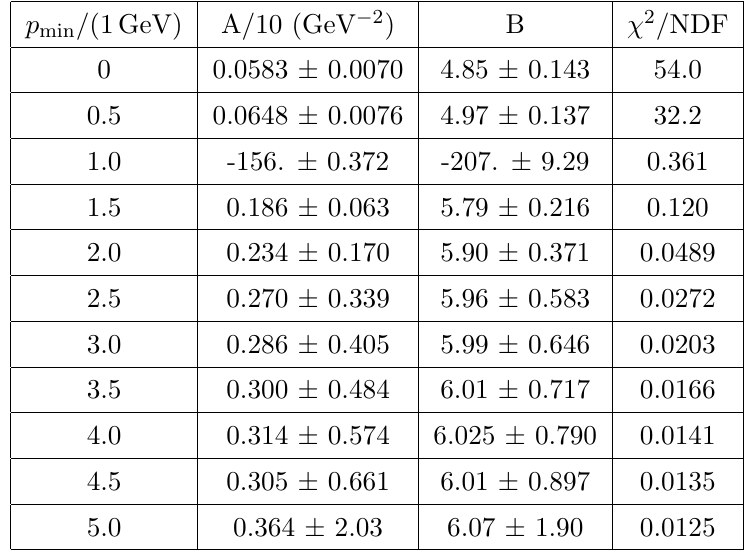
Table 4. Fitted values of parameters in eq. (E.2) for the ATLAS dataset at p s = 13 TeV [93].